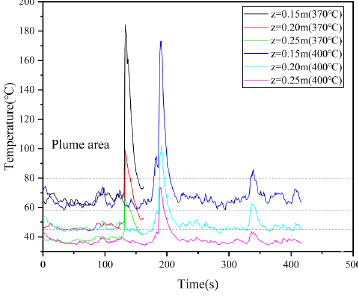
Fig. 5. Temperature distribution of the fuel vapor plumes at the different